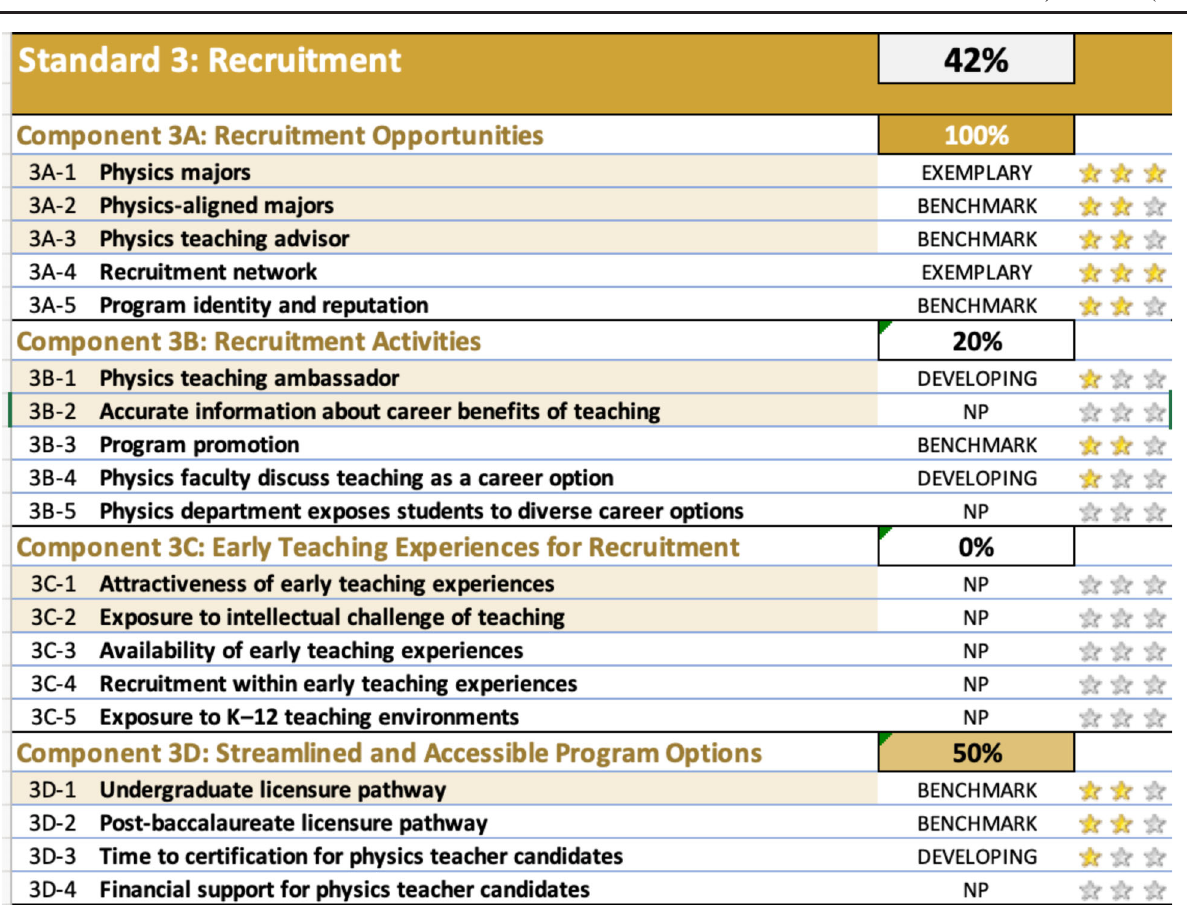
FIG. 3. Item-level report from the PTEPA interactive rubric (Excel format). Shaded items are prevalent (see Sec. IV D). Percentages shown are the percent of items within that component or standard that are at least at benchmark level.